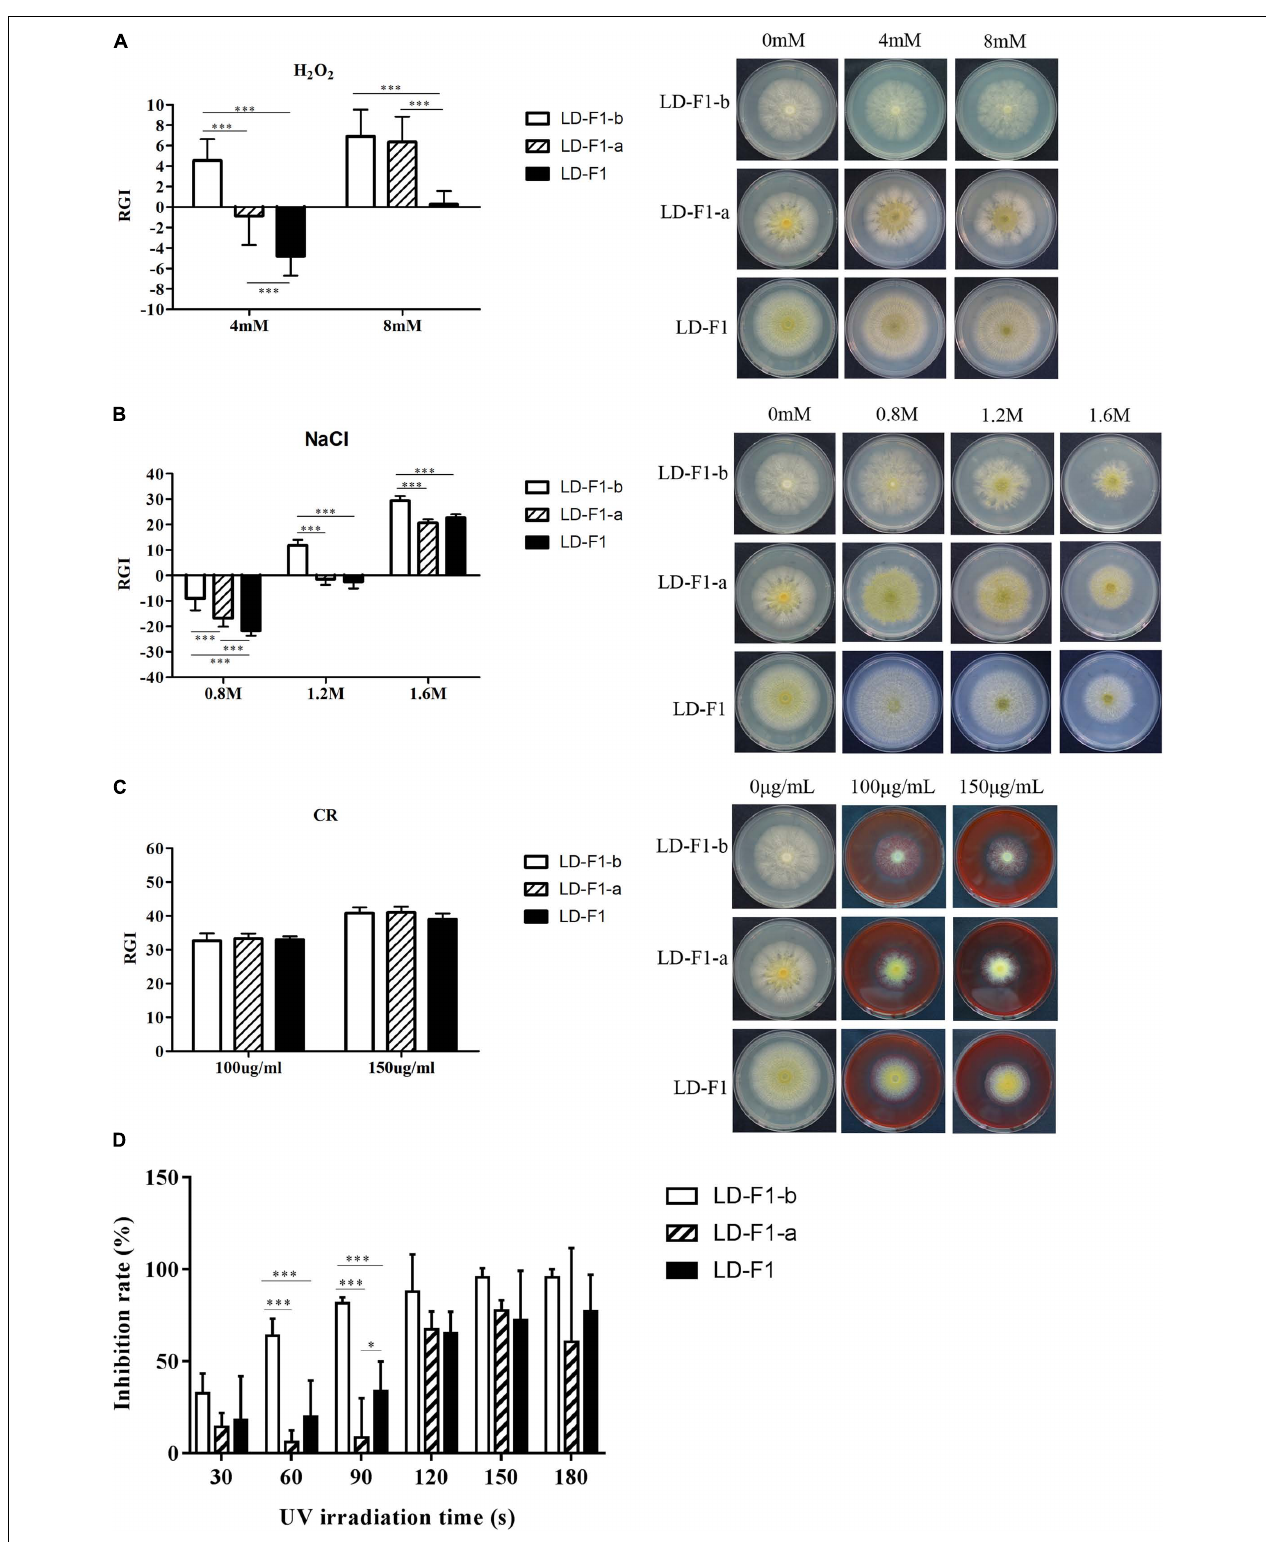
FIGURE 4 | Comparisons of tolerance to stresses by virus-free isolate (LD-F1), AfPV1-infected isolate (LD-F1-b), and AfPV1- and SatRNA-infected isolate (LD-F1-a). Radial growth inhibition under oxidative stress (A) , osmotic stress (B) , cell wall stress (C) , UV stress (D) . ∗ P < 0.05, ∗∗ P < 0.01, ∗∗∗ P < 0.001, by Tukey’s multiple comparison